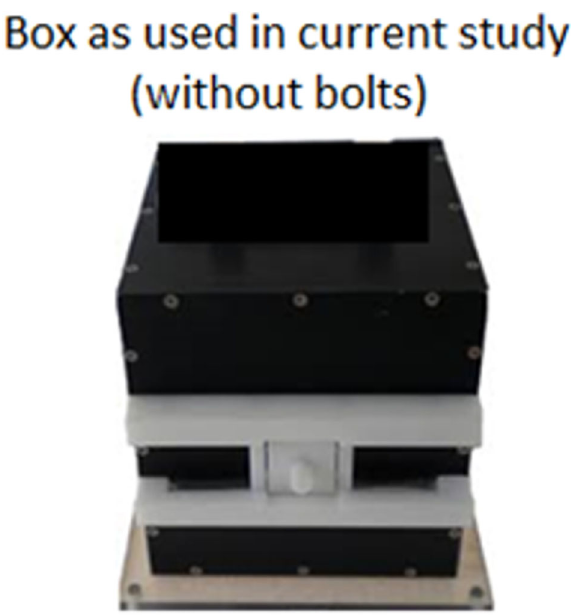
Fig. 1 The box used in the experiment. The only way to access the reward is through the door at the front.